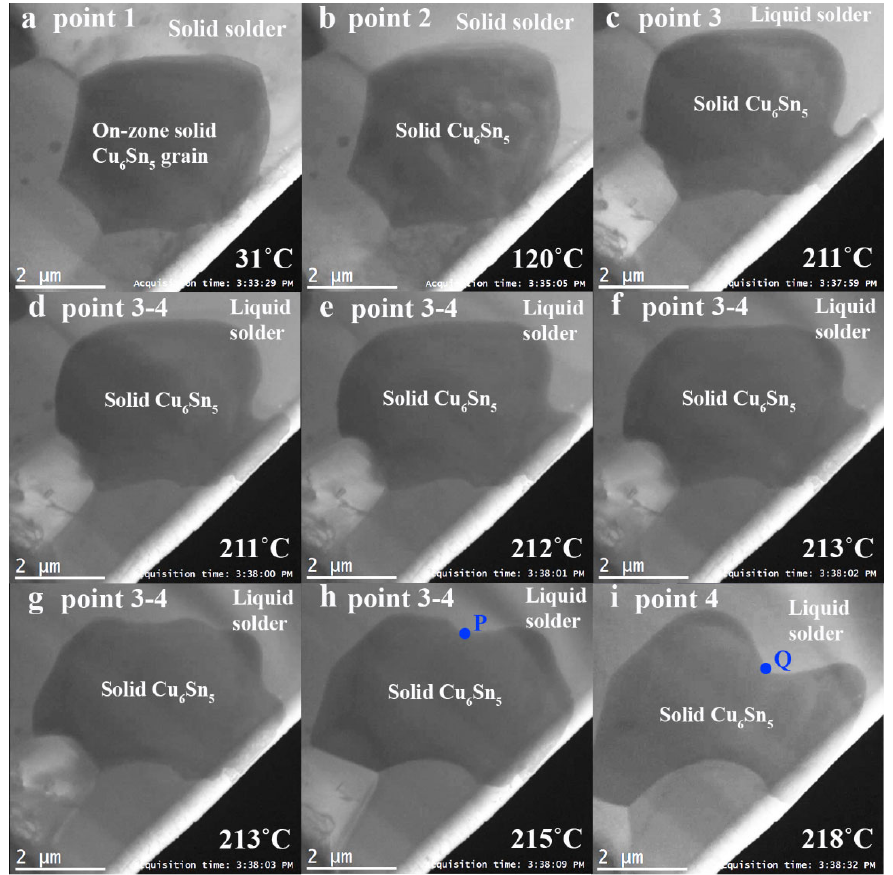
Figure 3. Snapshots of the heating experiment at each of the time intervals indicated in Figure 1c: ( a ) point 1, ( b ) point 2, ( c – g ) 1-s interval snapshots over a 4 s period highlighting the rapid grain boundary movements starting from point 3, ( h ) between point 3 and 4 at 215 °C and ( i ) point 4. Sample heating was stopped shortly after point 3 after the rapid morphological changes were observed. The temperature overshot to 218 °C at point 4, before cooling to a set temperature of 210 °C at point 5 and then 200 °C at point 6, and was maintained at this near ‐ isothermal temperature for 180 s. The rapid grain boundary movements contin ‐ ued through from point 3 to point 7 (Figures 3c–i and 4a–c). A second Cu 6 Sn 5 grain nucle ‐ ated at point 7 (Figure 4d), where a minimum temperature at 197 °C was measured. In Figure 4d, the video is zoomed out to a lower magnification to provide a view of the area surrounding the selected Cu 6 Sn 5 grain, where the grain boundaries of two adjacent grains are visible to the top ‐ left of the selected grain. The morphological changes became slug ‐ gish from this point onwards (Figure 4d,e), as the SAC305 solder solidified. At this stage, the bottom left of the Cu 6 Sn 5 grain has grown to less than 1 μ m from the Cu 3 Sn. From point 8 to 9, the sample was cooled to 190 °C. During cooling, the growth rate of the two Cu 6 Sn 5 grains accelerated (Figure 4e,f), as the dissolution limit of Cu in the SAC alloy re ‐ duced with temperature [11], and the excess Cu was deposited onto the Cu 6 Sn 5 grains. Gong et al. [11] state that the heterogeneous dissolution and growth may have resulted in the scallop morphology of the Cu 6 Sn 5 phase. The in situ observation in this study shows the Cu 6 Sn 5 grain does not have a scallop morphology during dissolution, and the scallop morphology is formed when Cu is deposited onto the Cu 6 Sn 5 grains during cooling.